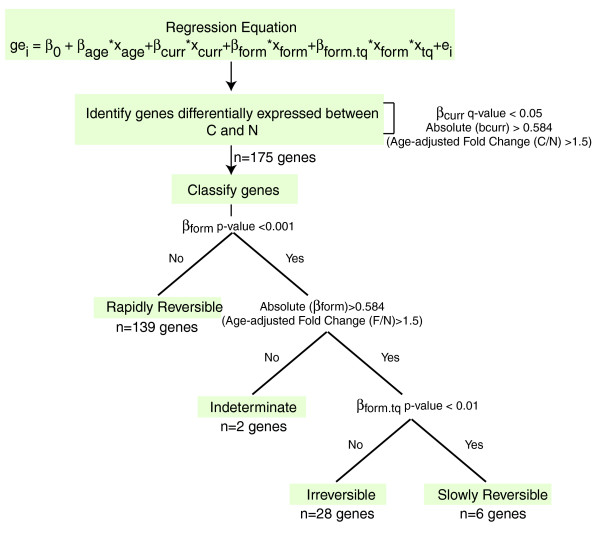
Methodology for gene classification by degree of reversibility upon smoking cessation. For each probeset, the relationship between gene expression in log2 scale (ge), age, current smoking status (xcurr), former smoking status (xform), and the interaction between former smoking status and months elapsed since quitting smoking (xtq) was examined with the linear regression model. Genes differentially expressed between current (C) and never (N) smokers were categorized based on their behavior in former smokers (F) relative to never smokers as a function of time since smoking cessation. Genes were classified as 'rapidly reversible' if there was not a significant difference between former and never smokers. Genes were classified as 'indeterminate' if there was a significant difference between former and never smokers, but the age-adjusted fold change between former and never smokers was not greater than or equal to 1.5. If the fold change criterion was met, genes were classified as 'slowly reversible' if there was a significant relationship between gene expression and time since quitting smoking or as 'irreversible' if there was not a significant relationship with time.